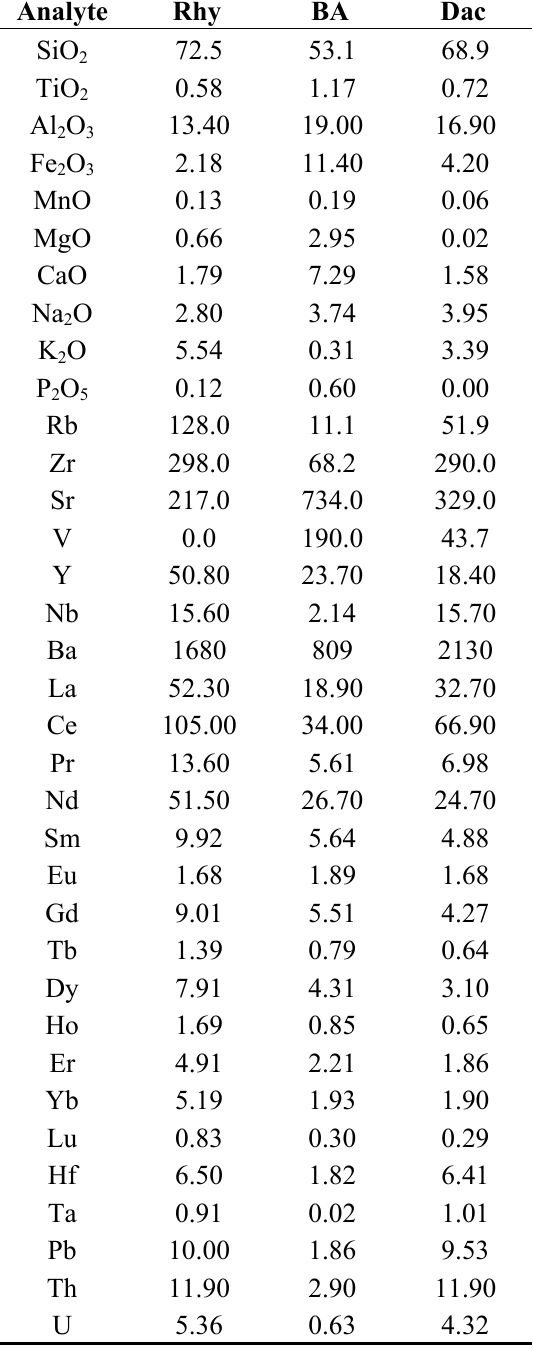
Table 2. Composition of end members determined by PVA for the three end member solution for all Papagayo samples. Major element oxides are listed in weight percent, and trace elements are in ppm. Rhy, rhyolite; BA, balsaltic andesite; Dac,